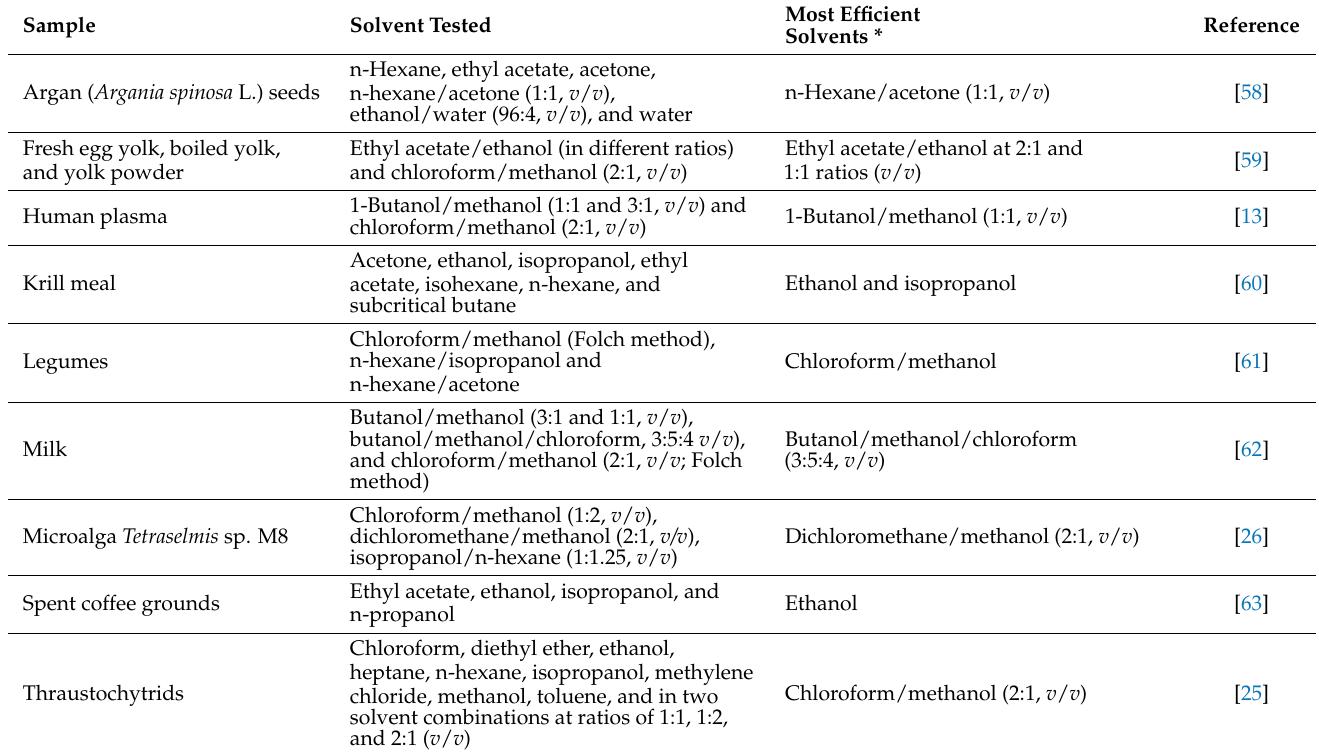
Most Efficient Solvents *